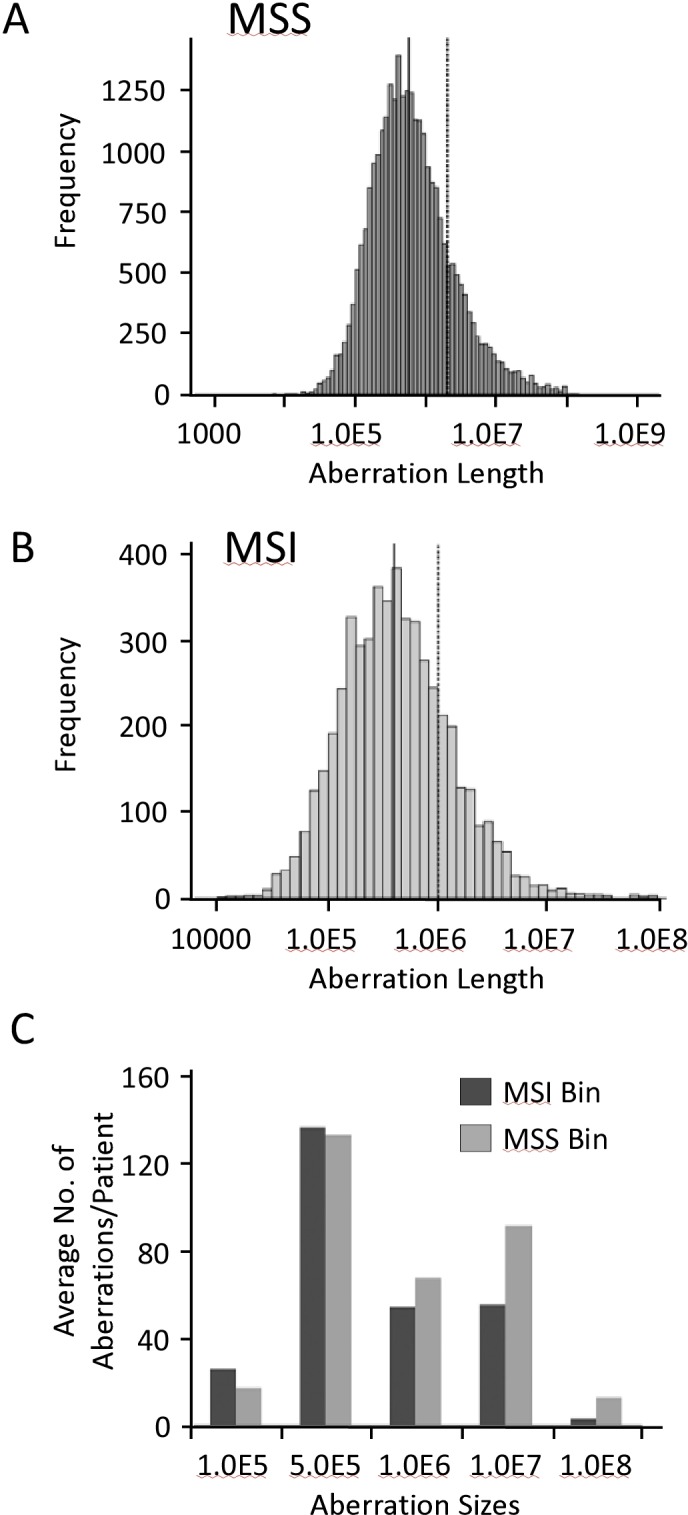
Aberrational frequencies in MSS (a) and MSI (b) CRC. The aberrational length X-axis in a and b are log transformed, with median shown as solid line and mean as dashed line. c) Shows the average number of genomic aberrations per patient in MSI and MSS CRC.